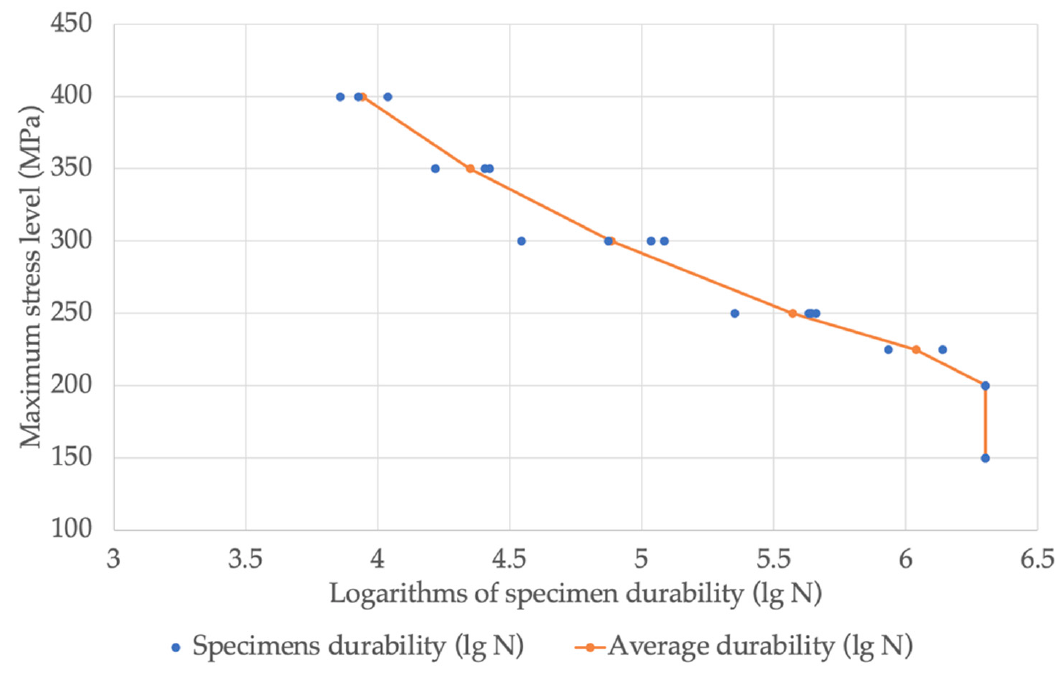
Figure 8. Durability of VT-14+Nb+Cu+12KH18N10T specimens obtained by diffusion welding during cyclic tests.